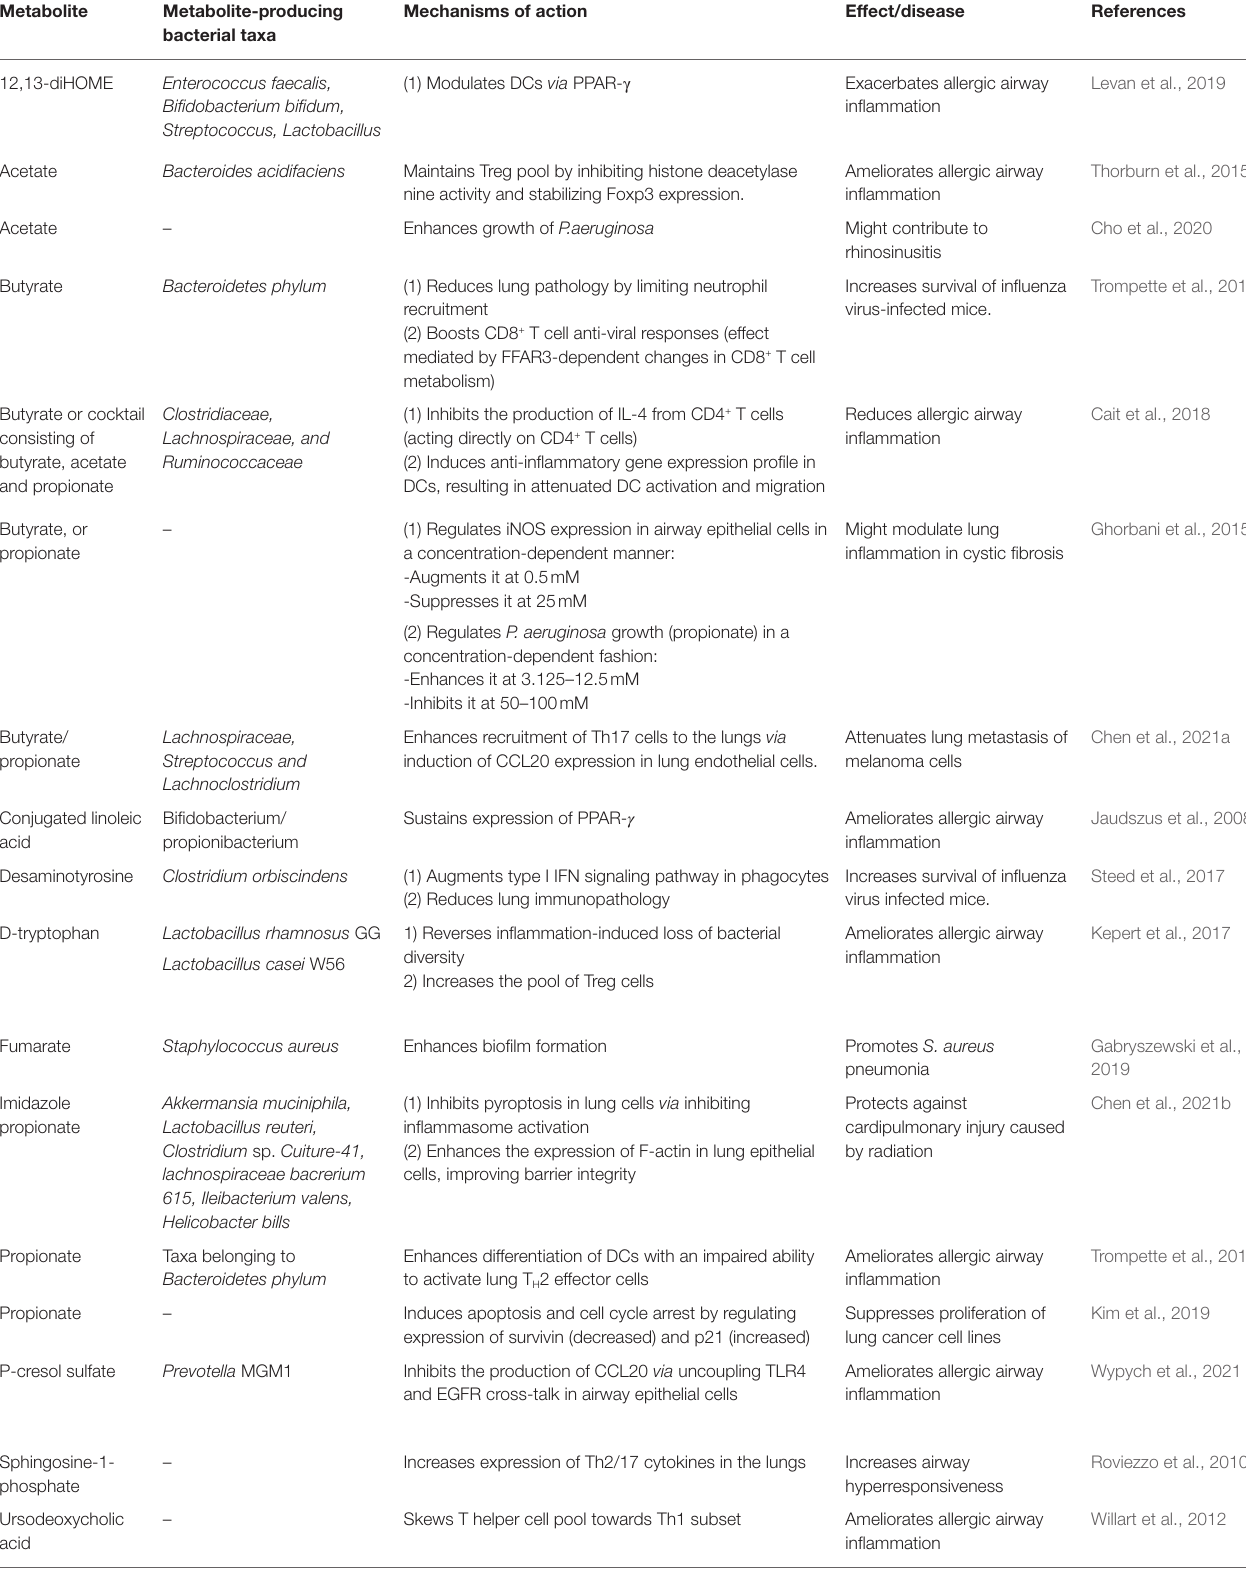
TABLE 1 | Microbial metabolites in mouse models of lung